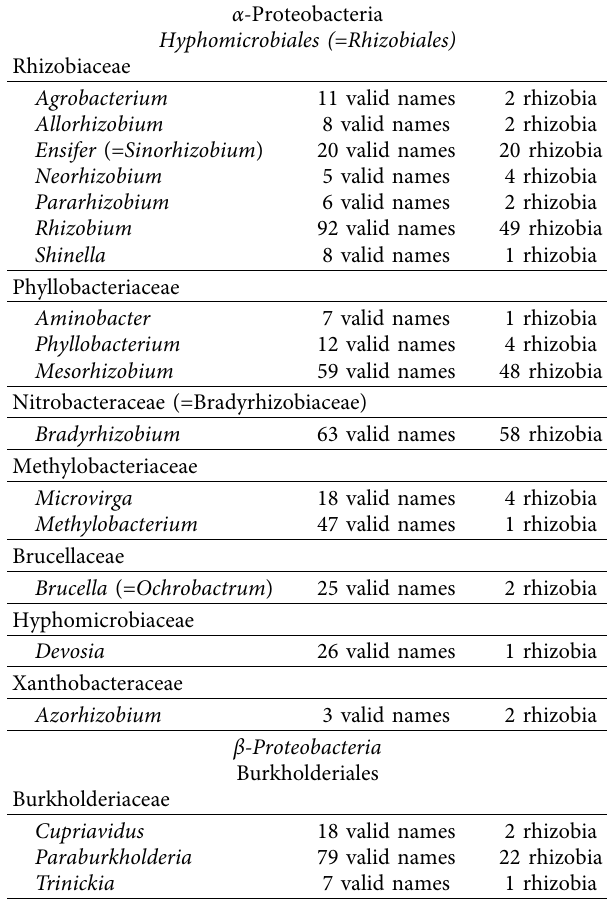
Table 1: List of genera comprising rhizobial species with valid names standing in nomenclature (LPSN) in October 2021. The number of valid names does not include